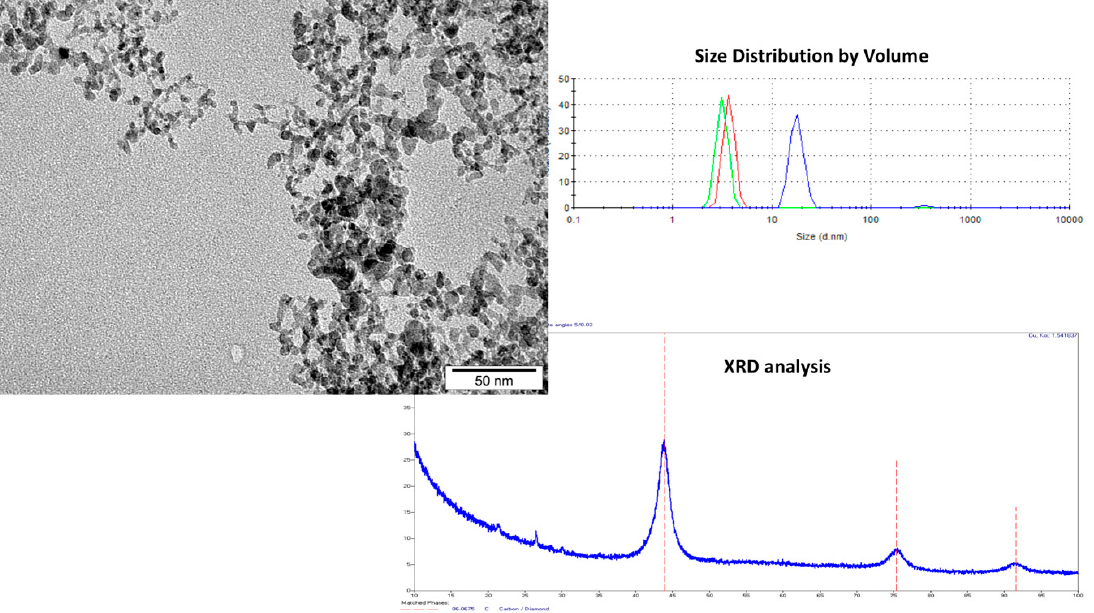
Figure 1. Physicochemical analyses (TEM, DLS, XRD) of diamond nanoparticles (NDs). Scale bar represents 50 nm. TEM, transmission electron microscopy; DLS, dynamic light scattering; XRD, X-ray diffraction.